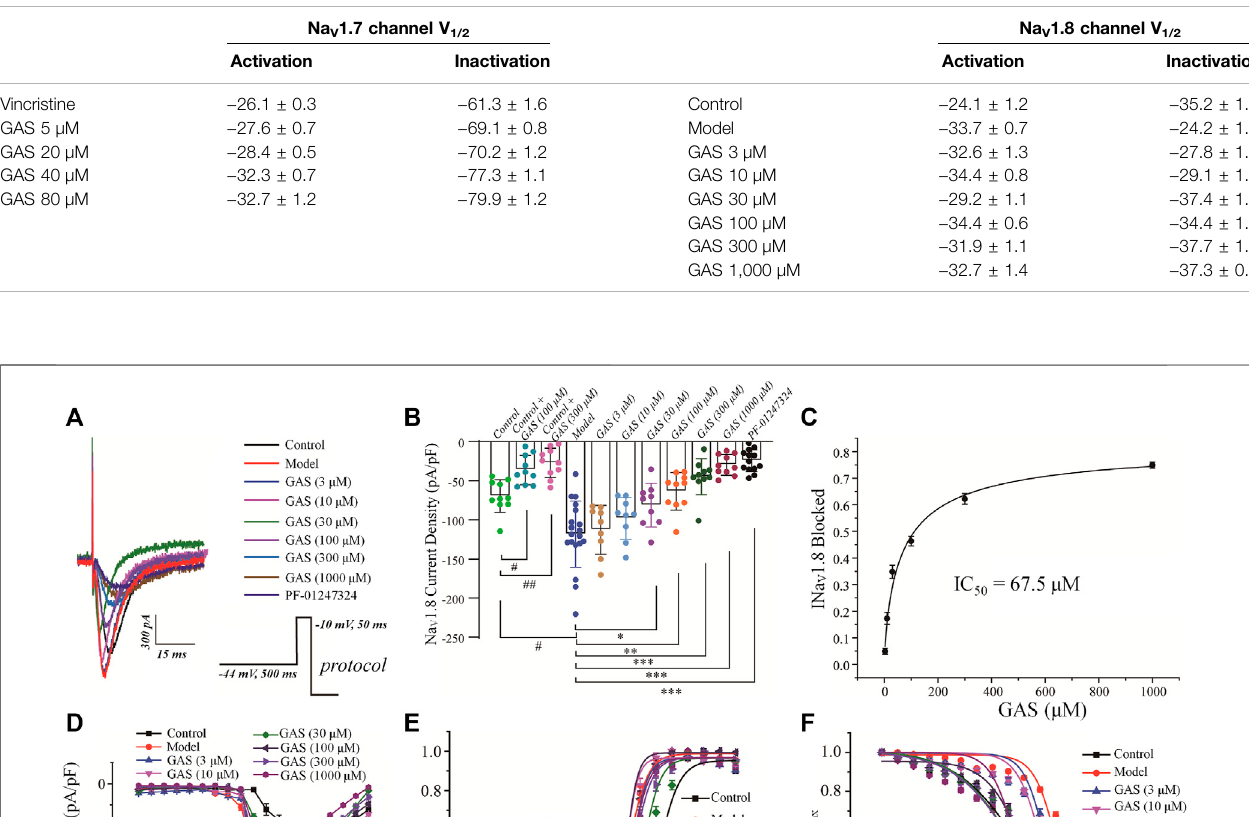
TABLE 2 | The effect of GAS on V 1/2 of Na V 1.7 channel and Na V 1.8 channel in cells.